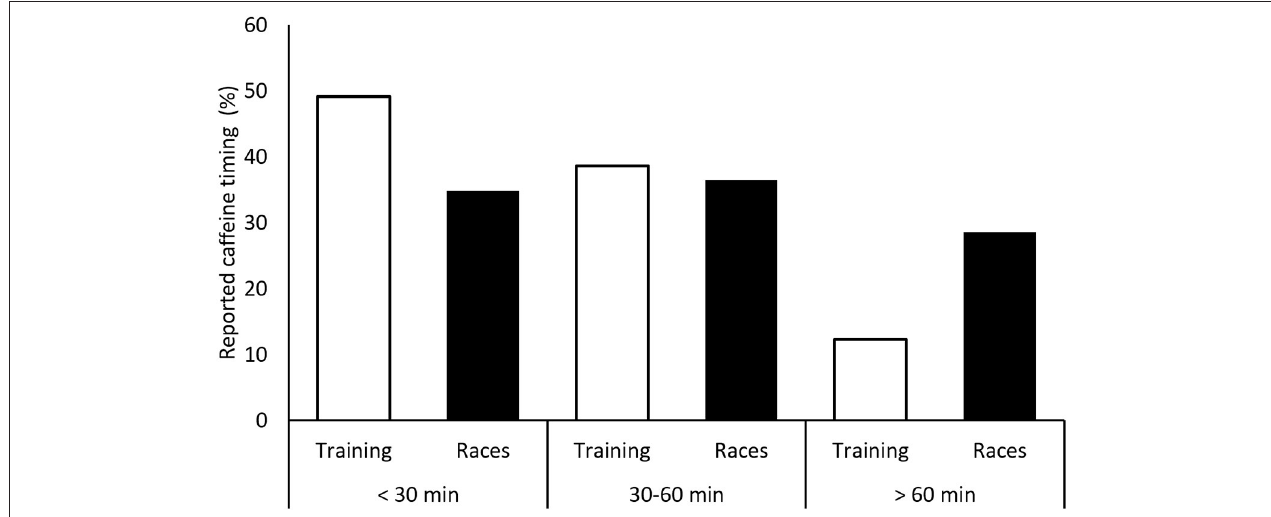
FIGURE 2 | Reported caffeine intake timing prior to training and races.